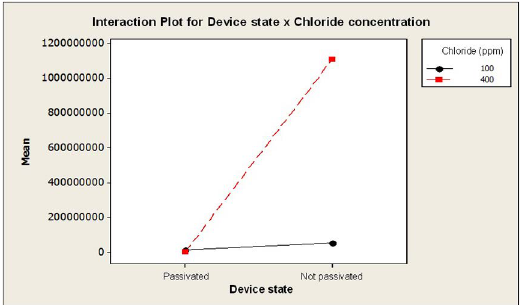
Figure 7. Interaction plot for BA, device state x chloride concentration